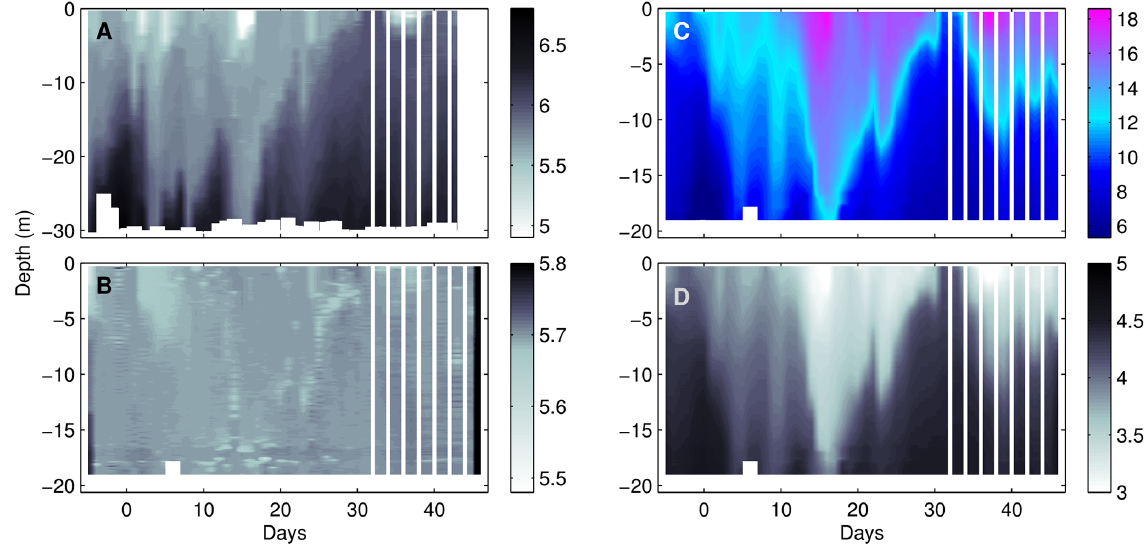
Figure 5. CTD profiles taken between t − 5 and t 46 for (a) salinity of surrounding water (Baltic), and (b) salinity, (c) temperature ( ◦ C), and (d) density anomaly of M8 ( σ T in kgm − 3 ) . M8 profiles are representative of all mesocosms. White vertical lines indicate CTD profiles were taken every second day after t